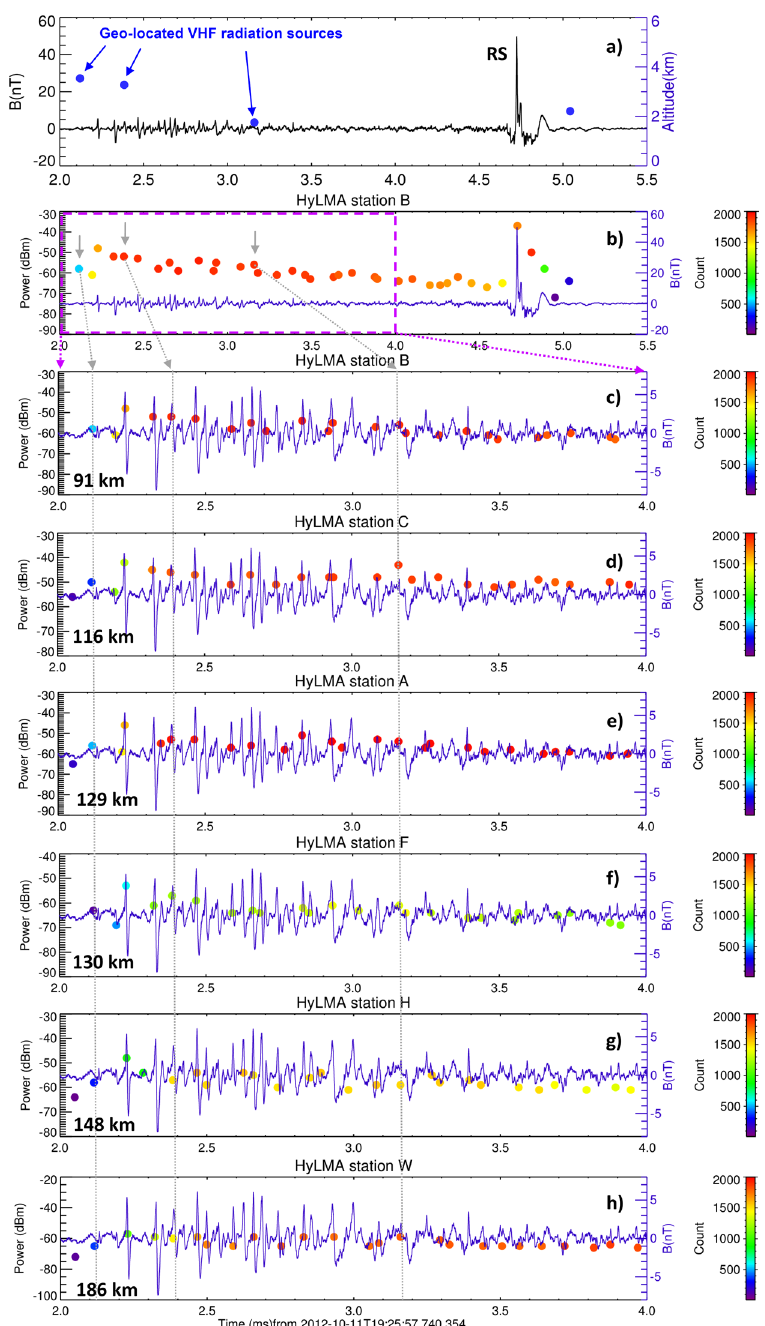
Figure 2. Example of a negative cloud-to-ground discharge from the 2012 dataset. A continuous broadband waveform recorded by BLESKA showsa sequence of PB pulses and the corresponding return stroke pulse (11 October 2012, 19:25:57.7 UTC, 5.30°E, 43.73°N) with ( a ), geo-located VHF radiation sources including their occurence altitudes from HyLMA (blue dots) and ( b ), peaks of radiated VHF power recorded at the closest HyLMA station B. The dots representing the occurrence of strongest VHF peaks are color-coded by the number of intense VHF samples recorded in the corresponding 80 µ s LMA windows. The power of the strongest peak of radiated VHF power in the corresponding windows is shown on the left-hand vertical axis. ( c–h ) Plots show a 2-ms long detail of the same PB pulse sequence with the peaks of radiated VHF power detected at different HyLMA stations (B, C, A, F, H, and W). Gray arrows and lines identify the geo-located VHF radiation sources occurring within the pre-stroke period of the observed discharge with peaks of radiated VHF power recorded at individual stations. Propagation time between the discharges and the different sensors is taken into account to provide accurate temporal overlays. The expected accuracy of temporal overlays of broadband magnetic-field measurements and LMA detections is several µ s but the LMA system reports only one (the strongest) peak of radiated VHF power in each 80 µ s wide